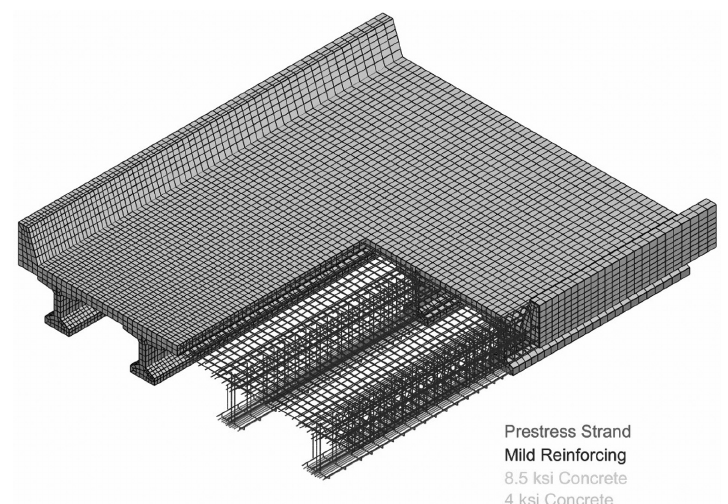
Fig. 17. Finite element model for the bridge deck.